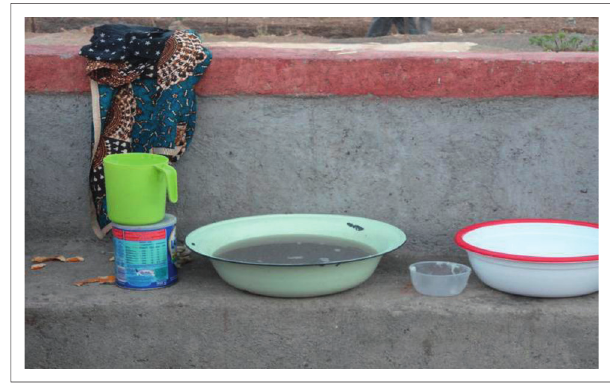
FIGURE 3: Dirty water used for washing dishes.